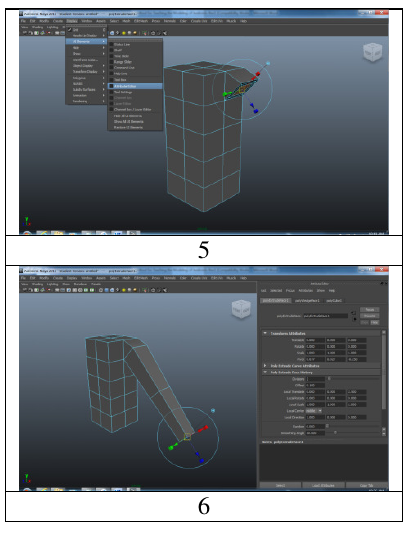
Figure 13. Extrude operation